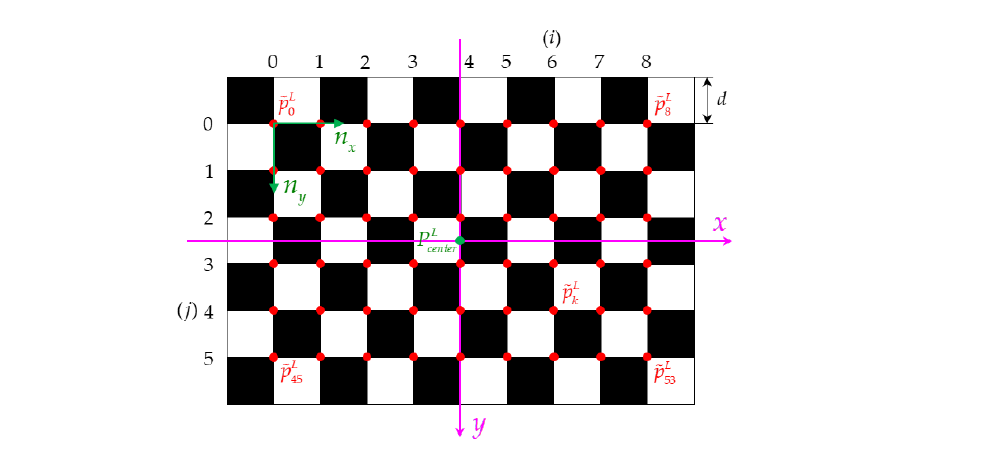
, as shown in Figure 5.